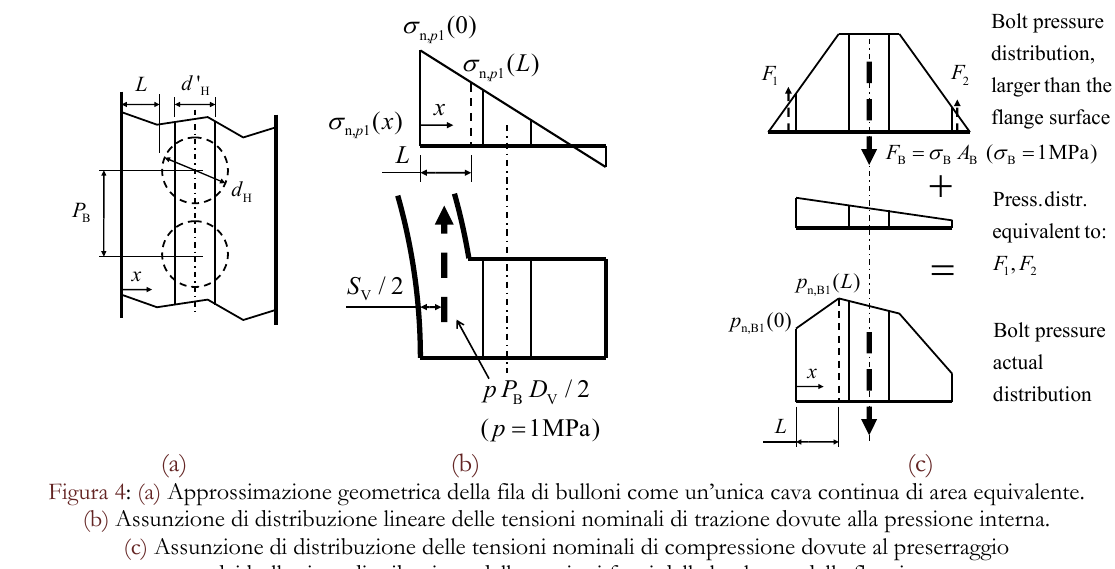
Figura 4: (a) Approssimazione geometrica della fila di bulloni come un’unica cava continua di area equivalente. (b) Assunzione di distribuzione lineare delle tensioni nominali di trazione dovute alla pressione interna. (c) Assunzione di distribuzione delle tensioni nominali di compressione dovute al preserraggio dei bulloni, re-distribuzione delle tensioni fuori dalla larghezza della